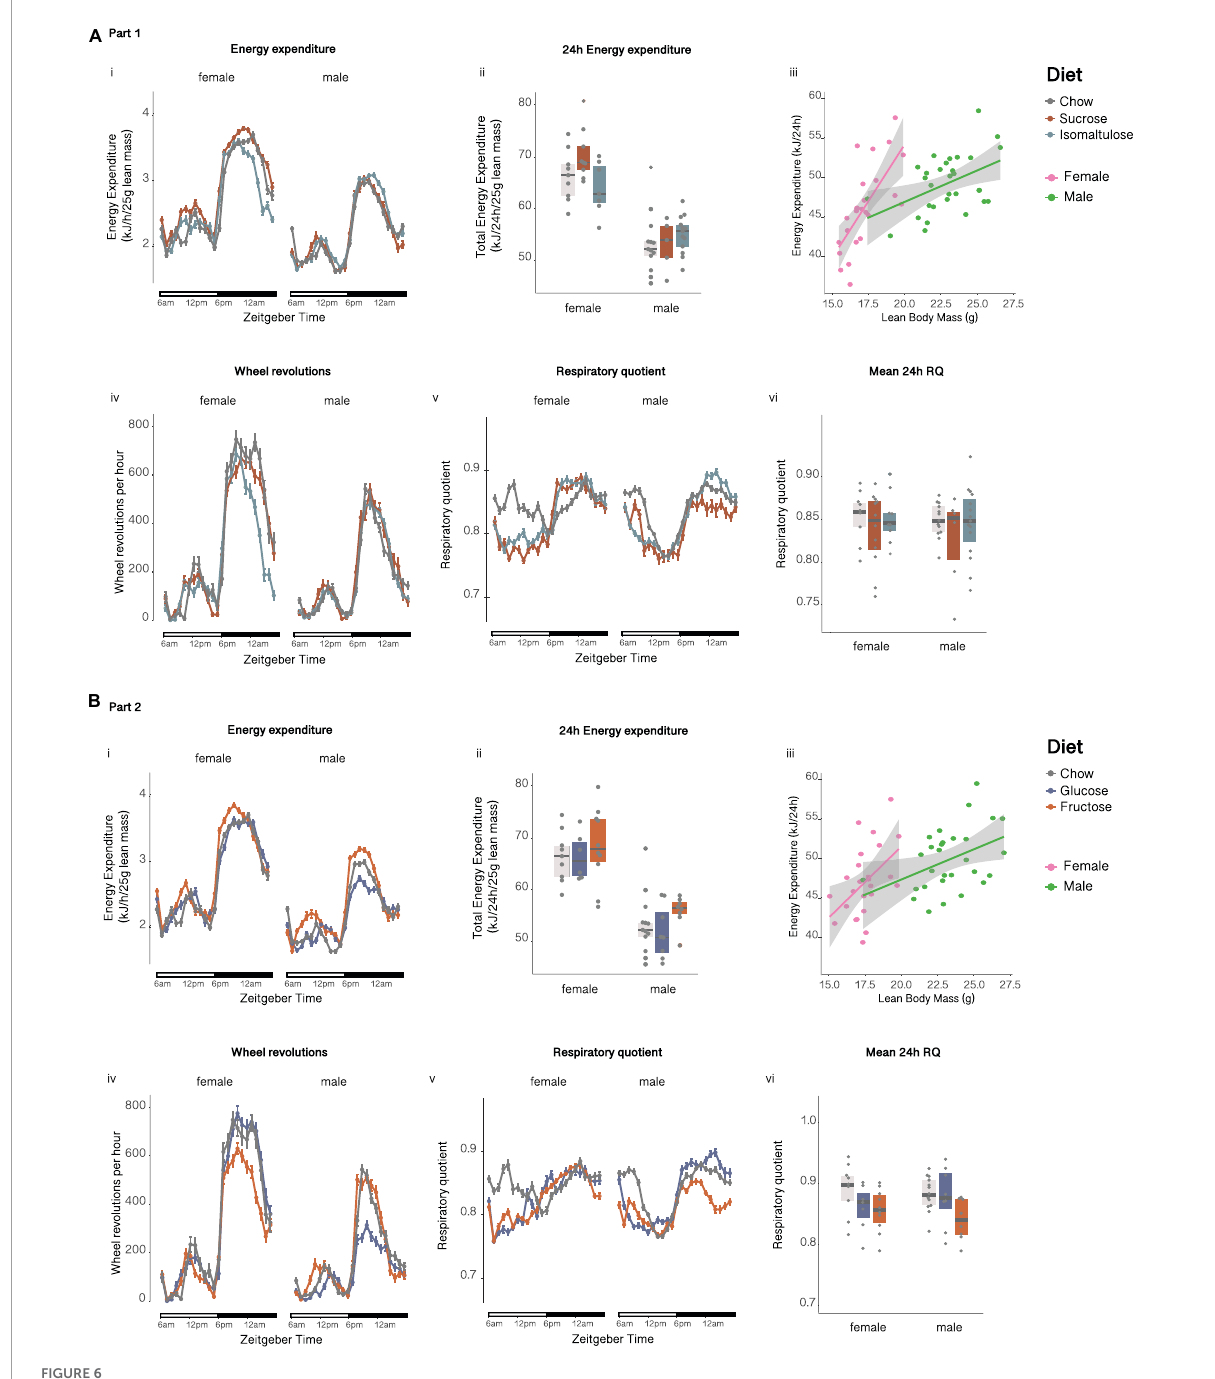
FIGURE6 Metabolic phenotyping of female and male pups at 12 weeks of age (A) in Part 1 and (B) in Part 2: Pup (i) energy expenditure over time, (ii) total energy expenditure, (iii) correlation of energy expenditure and lean mass, (iv) wheel revolutions, (v) respiratory quotient over time and, (vi) respiratory quotient. n = 10–26 per diet per sex. Line graphs depict data as mean ± SEM.